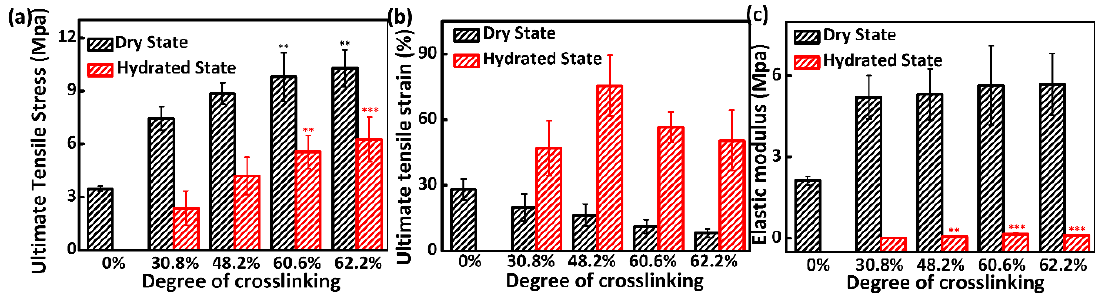
Figure 4. Ultimate tensile stress ( a ), ultimate tensile strain ( b ) and elastic modulus ( c ) of nanofibrous membranes varied as function of degree of crosslinking (Significant differences were marked by *** for p < 0.001; ** for p < 0.01 compared to the 30.8% crosslinked sample).